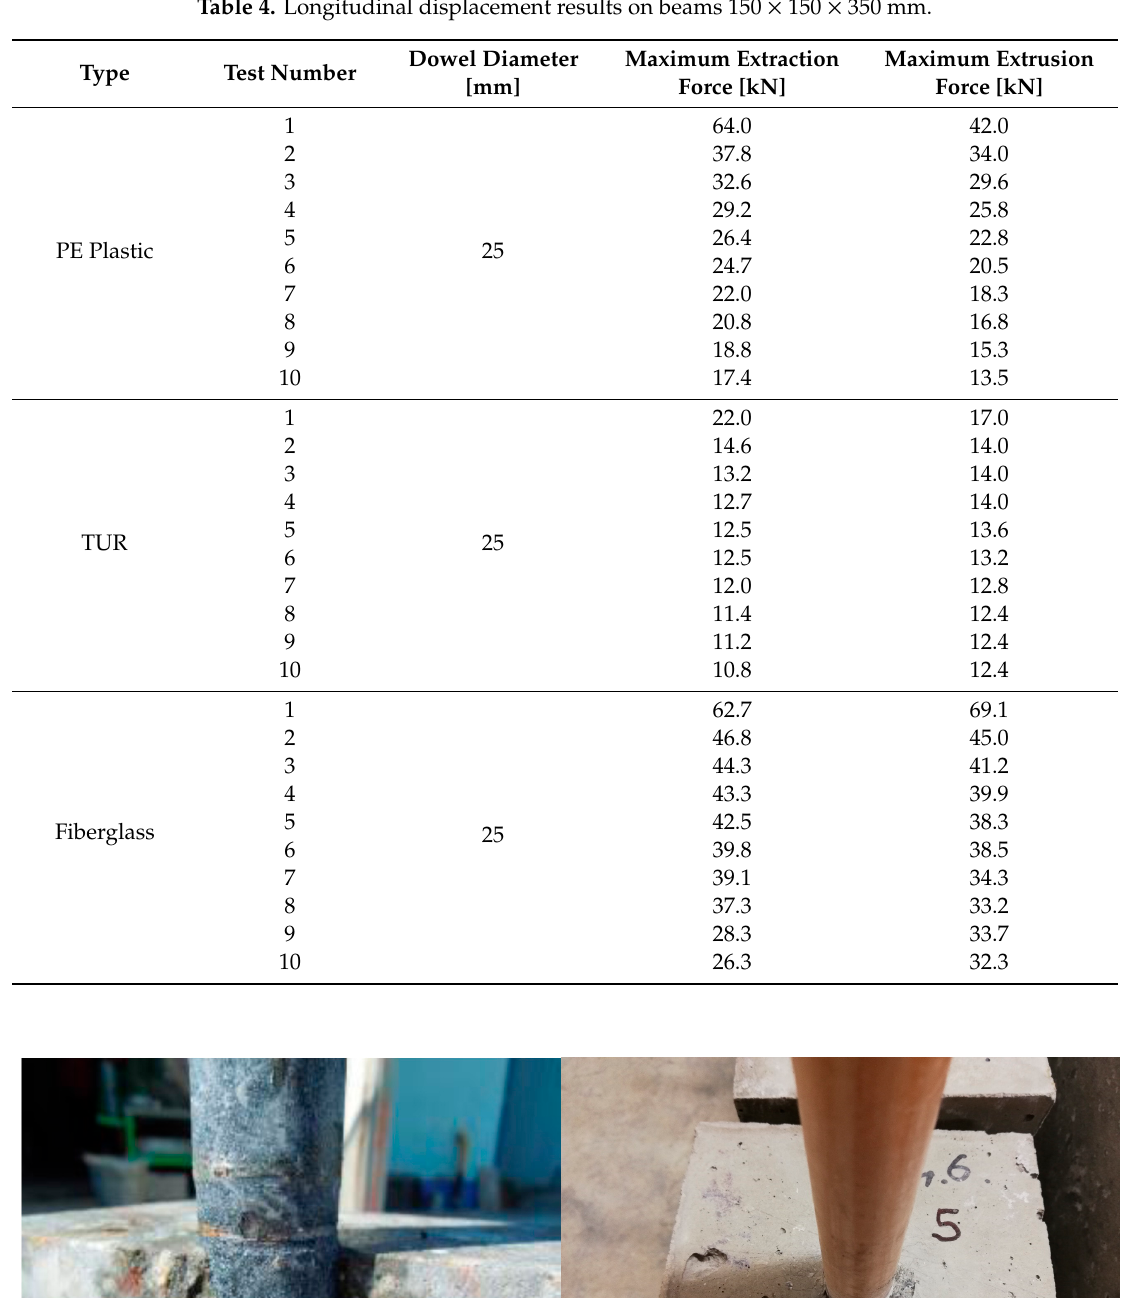
Table 4. Longitudinal displacement results on beams 150 × 150 × 350 mm.